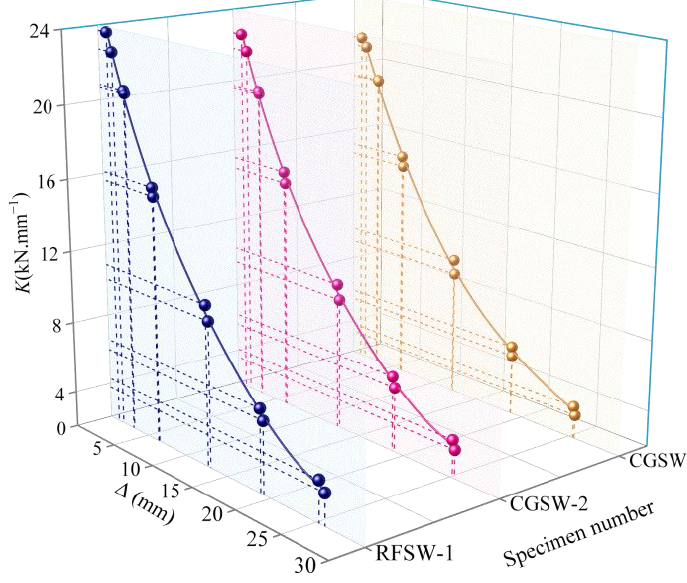
Figure 13. Secant stiffness degradation curves of the specimens.